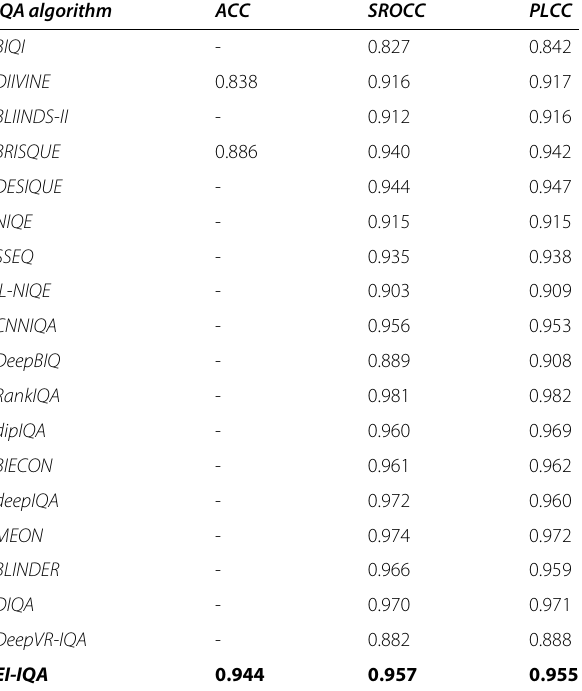
Table 7 Test results on CSIQ database